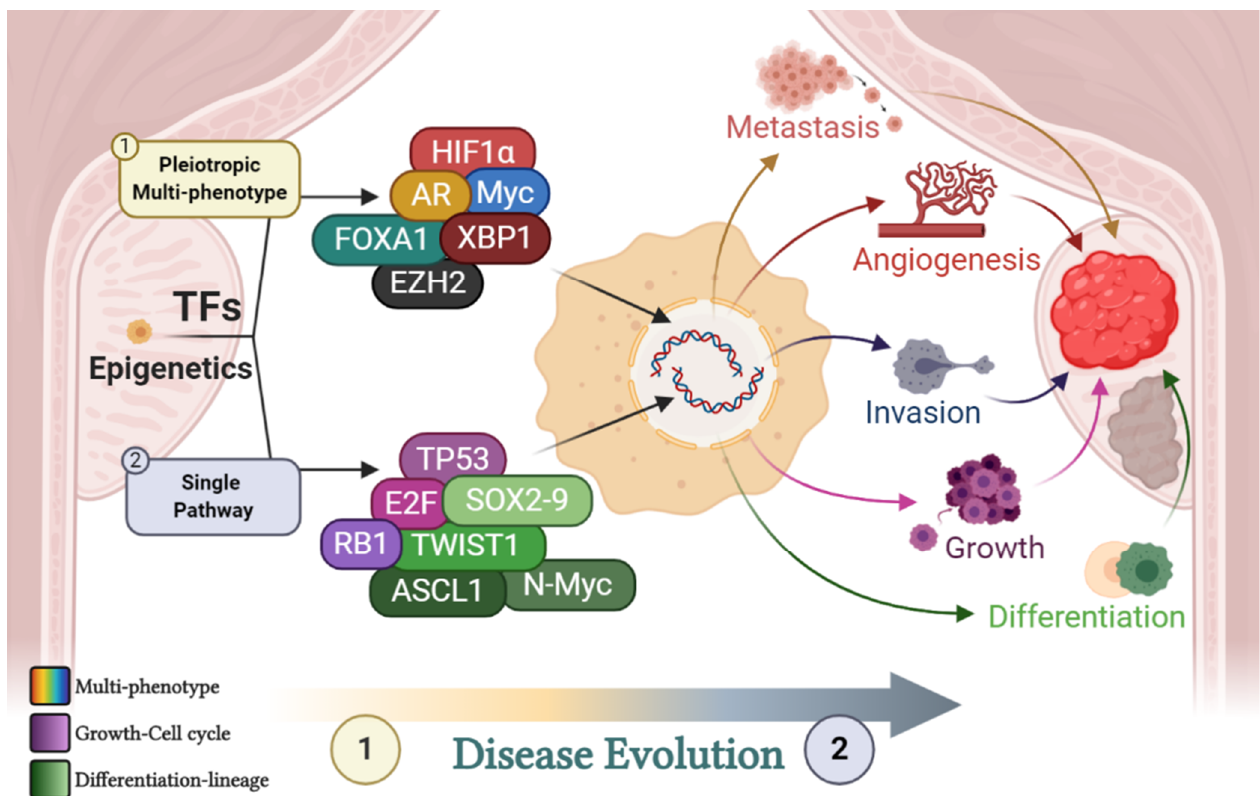
Figure 1. Contribution of transcription factors (TFs) to disease progression. Multiple transcription factors and epigenetic modifiers contribute to disease progression. Some are pleiotropic and affect multiple key biological pathways (multi-colored). Others (although affecting several systems in a global way) predominantly affect single key developmental and biochemical pathways such as growth (purple array) and lineage determination or differentiation (green array). Moreover, pleiotropic TFs may be predominantly active at an early stage in disease evolution, whilst single pathway TFs are most prominent later in disease progression. This is exemplified by the phenomenon that localized prostate cancer (PCa) does not display a high proliferative index or huge fluctuations in the prostate-specific antigen (PSA) level prior to treatment (a marker of a transformed, differentiated prostate). As such, TFs are ever-present throughout disease evolution and collaborate to promote tumor differentiation, growth, angiogenesis, invasion, and metastasis. The purple array includes tumour protein 53 (TP53), E2 factor (E2F) and retinoblastoma protein (RB1). The green array includes the twist family BHLH transcription factor 1 (TWIST1), achaete-scute family BHLH transcription factor 1 (ASCL1), N-Myc and the sex determining region Y-box 2 (SOX) TF family. Individual TFs include the androgen receptor (AR), enhancer of zeste homologue 2 (EZH2), x-box binding protein 1 (XBP1), forkhead box A1 (FOXA1), Myc and hypoxia inducible factor 1 (HIF1alpha). Created with BioRender.com.